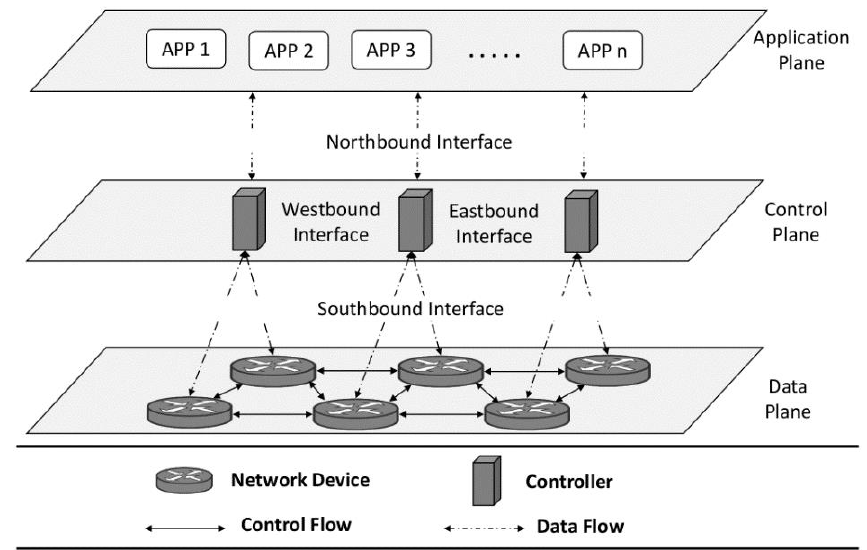
Figure 1. Software Defined Networking (SDN) General Architecture .